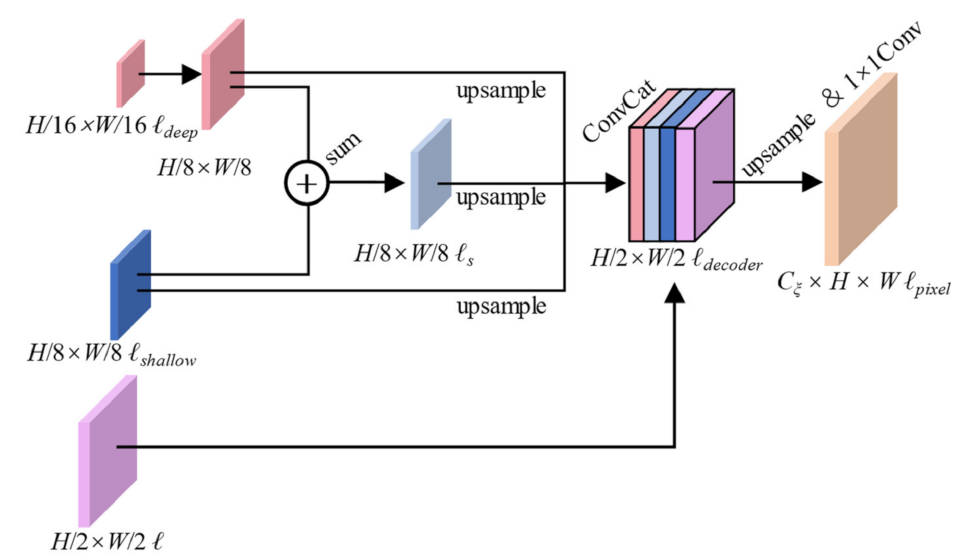
Figure 3. The structure of the Supplementary Aggregation Decoder.